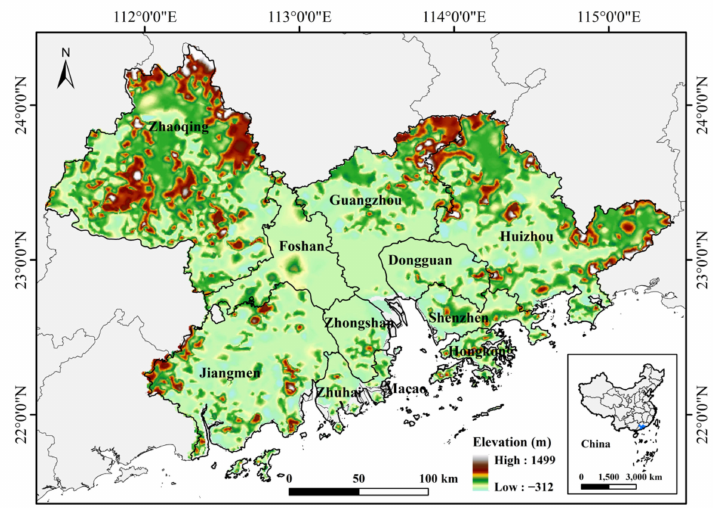
Figure 1. Location and topography map of the study